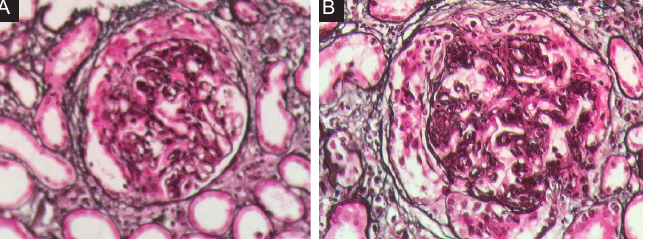
Figure 1. Two glomeruli show prominent cellular crescents formation compressing the native glomerular tufts. (A) The crescent partially covers the tuft. There is mild interstitial inflammatory cell infiltrate in the surrounding parenchyma (Jones’ silver stain ×200). (B) The crescent is circumferentially covering the entire tuft. Mild periglomerular inflammatory infiltrate is present (Jones’ silver stain